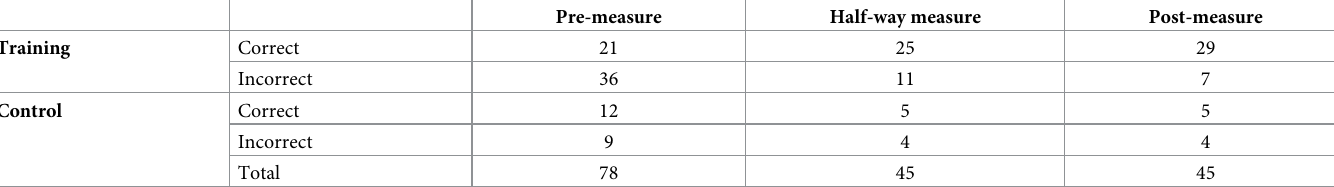
Table 3. Descriptive statistics of the incubation effect between the training and control groups at pre-measure, half-way measure and